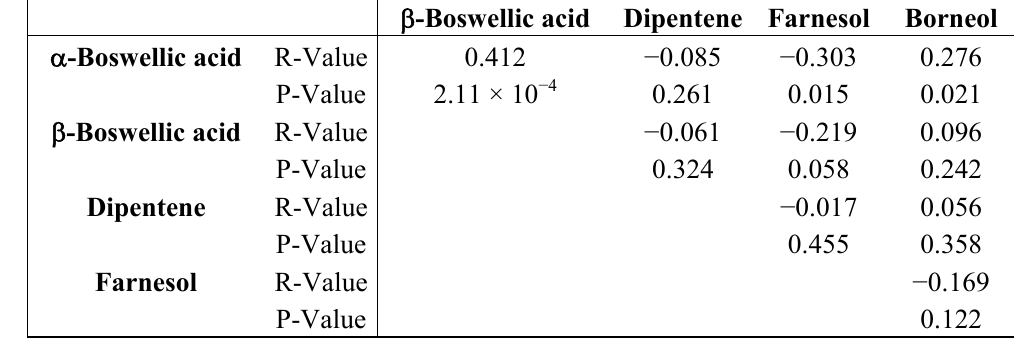
values by Pearson’s correlation test. 50